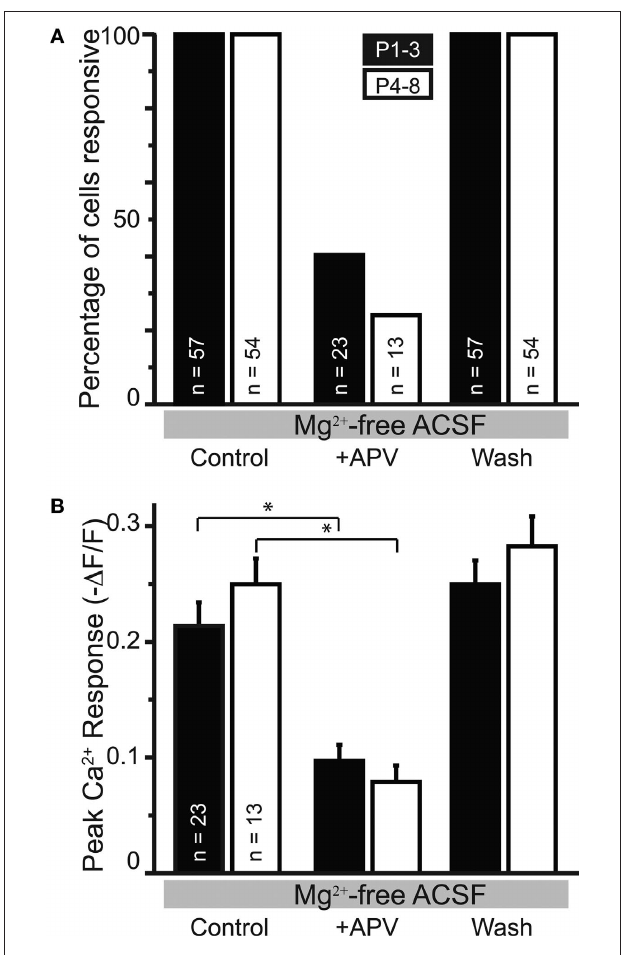
FiGUre 7 | APV-sensitive somatic Ca 2 + responses in nominally Mg 2 + -free ACSF. (A) The percentage of cells responsive to MNTB stimulation following APV application decreased in slices from PI–3 and P4–8 animals. (B) In the cells responsive in APV, the peak amplitude was reduced in APV compared with control conditions in both age